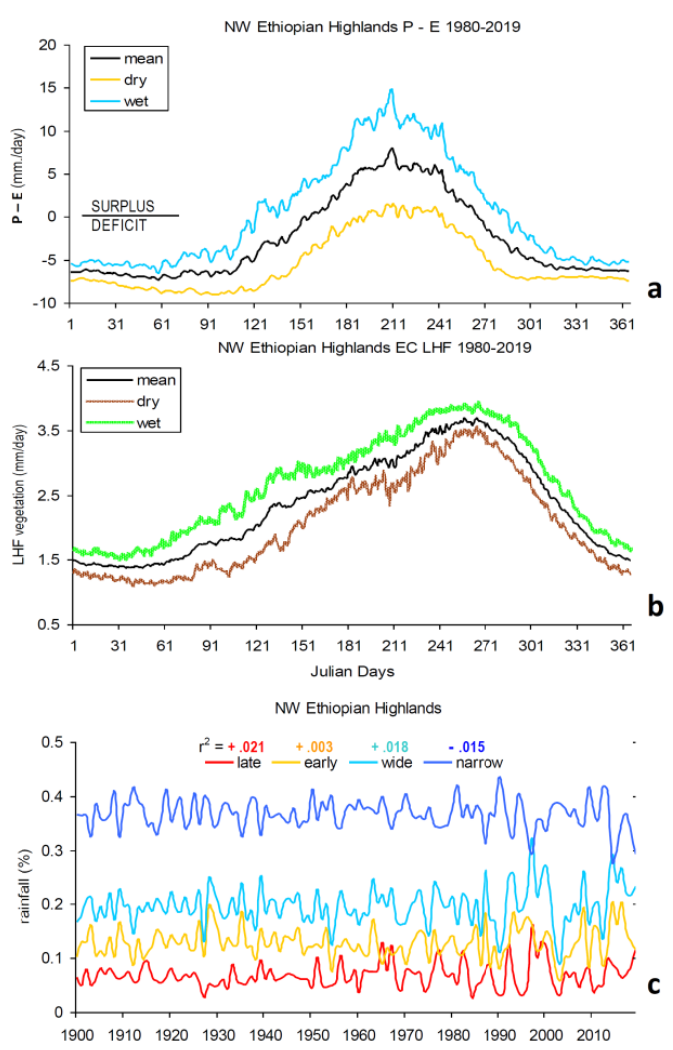
Figure 2. Annual cycle terciles from daily data 1980–2018: ( a ) Seasonal precipitation (P) minus E and ( b ) ECMWF LHF ‘vegetation’ proxy. ( c ) Seasonal contributions of cenTrends P over the 20th century, where late = Oct.–Nov., early = Apr.–May, wide = early + late, narrow = Jul.–Aug. only. All time series averaged in the study area: 8.5–13 ◦ N, 35–39.5 ◦